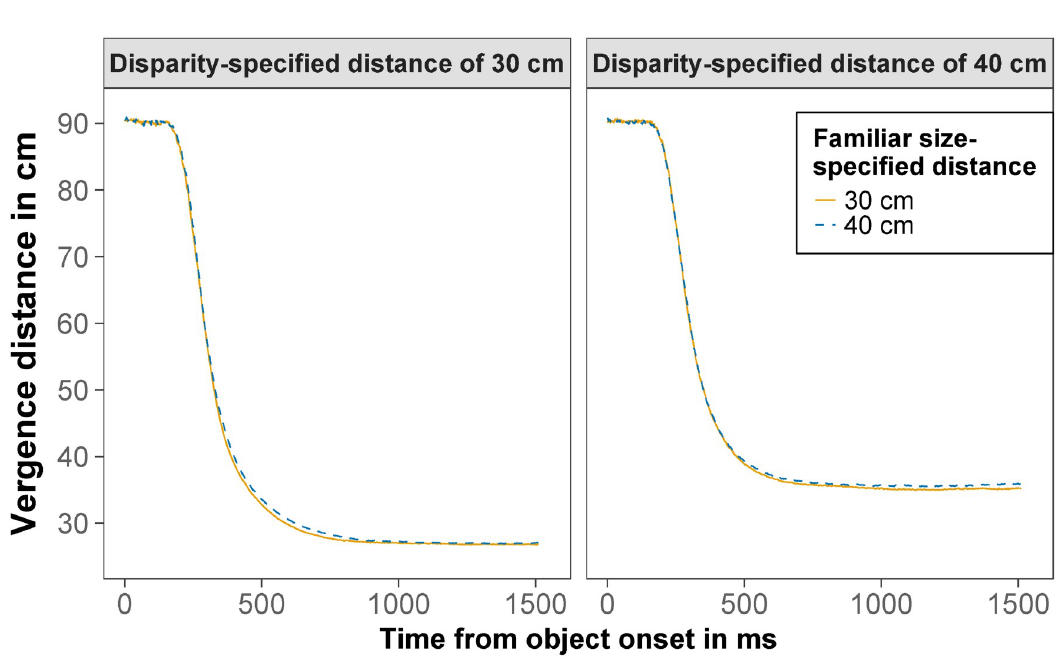
Fig 4. Vergence distance course. Mean vergence distance for a binocular disparity-specified distance of 30 cm (left) and 40 cm (right) and a familiar size-specified distance of 30 cm (solid orange) and 40 cm (dashed blue) as a function of time from object onset.